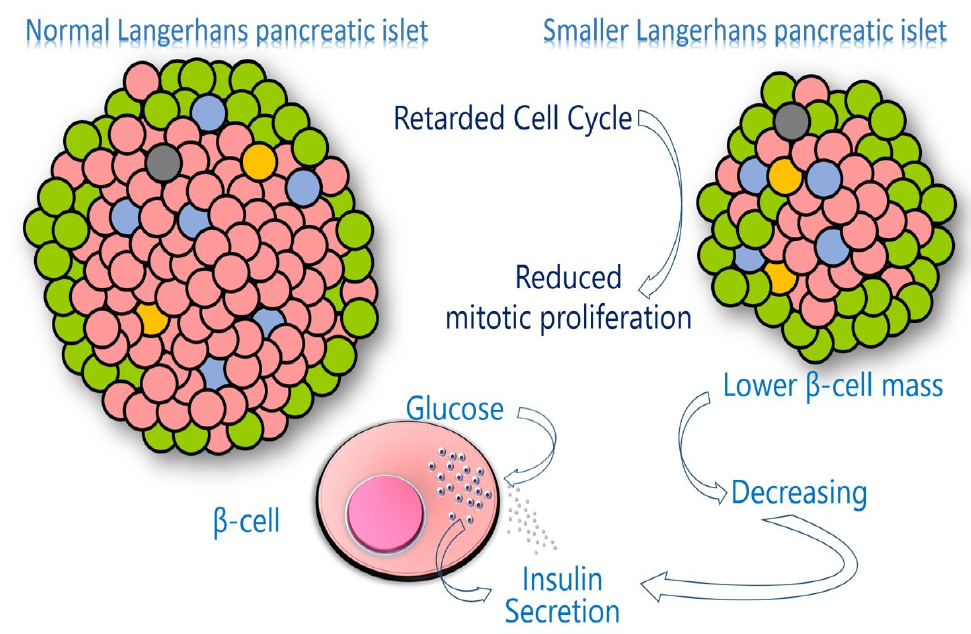
Figure 5. Development of type II diabetes mellitus in Turner syndrome. Located within the islets of Langerhans, pancreatic β -cells are sensitive to plasma glucose concentrations and secrete suitable amounts of insulin. Insulin exerts its action on the target peripheral tissues (liver, muscles, and adipocytes) to improve glucose utilization and storage. In Turner syndrome, a prolonged cell cycle leads to a decrease in and dysfunction of the pancreatic β -cell mass in an environment of increasing insulin resistance. Consequently, the lower pancreatic β -cell mass becomes “exhausted” early and cannot secrete adequate amounts of insulin to preserve normoglycemia.